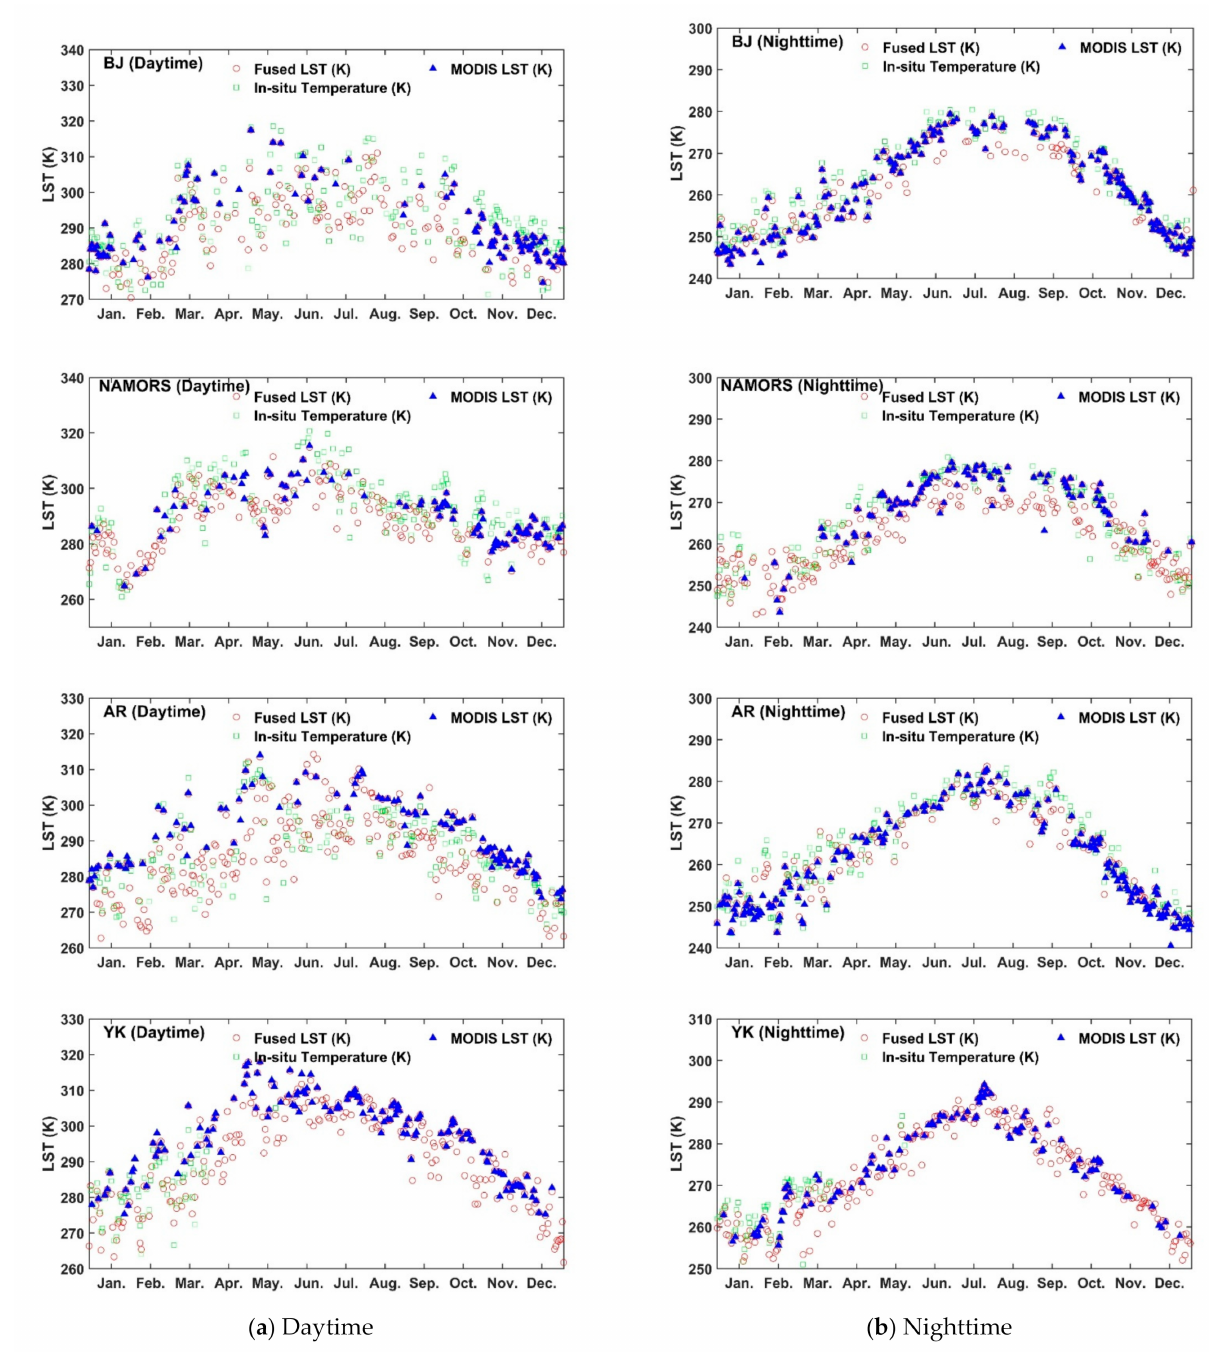
Figure 11. The daily variations of the fused LST, in situ temperature, and MODIS LST at each site: ( a ) daytime, ( b )